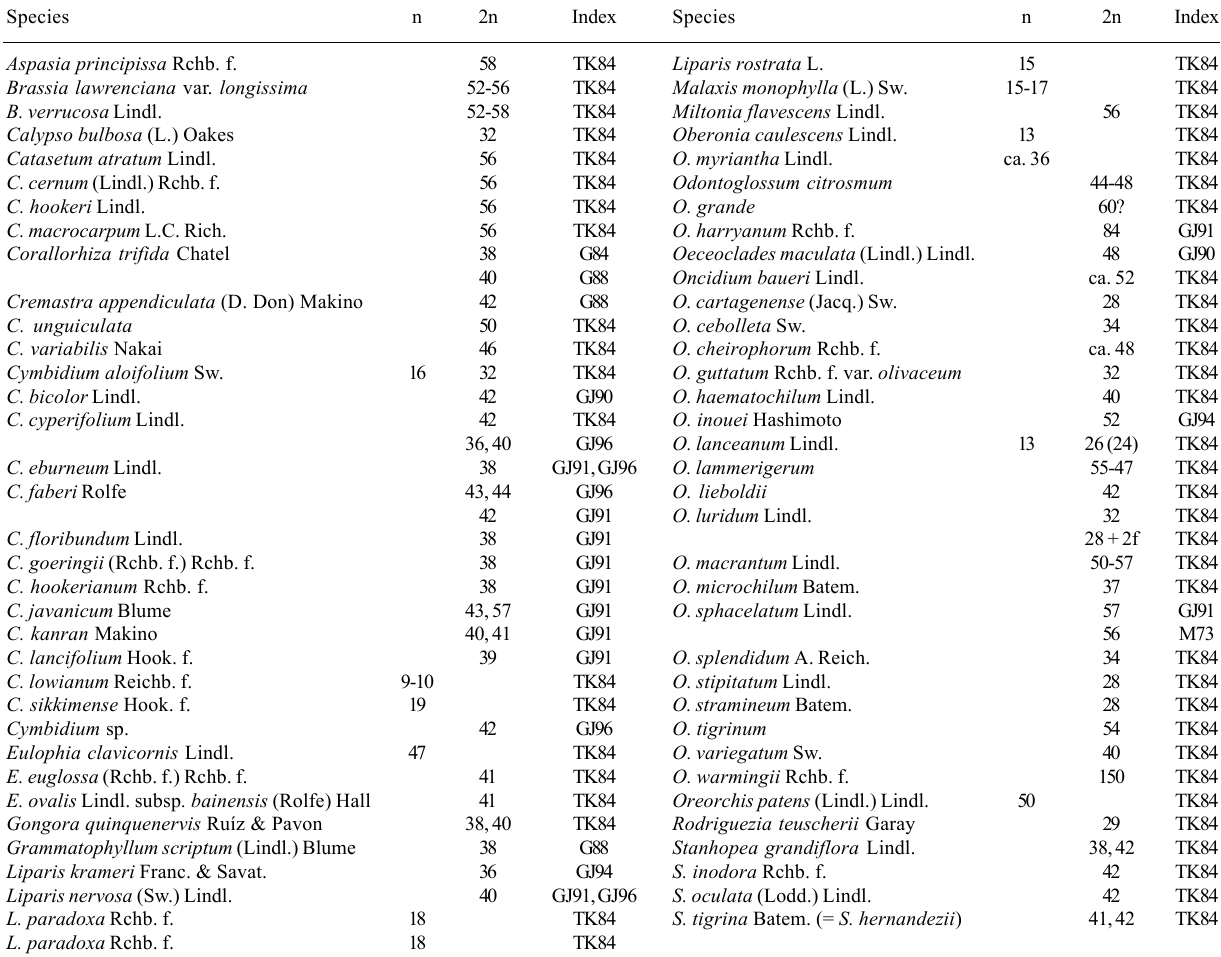
Table IV - Cymbidioid species with uncertain chromosome